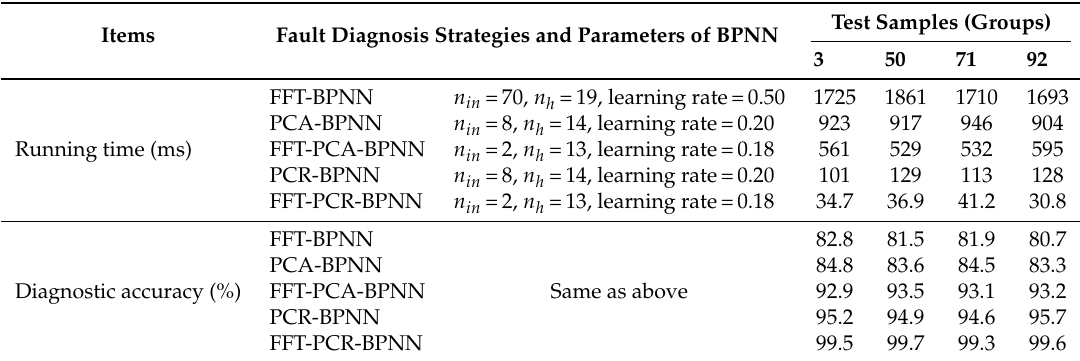
Table 4. Average fault diagnostic results based on different diagnosis strategies and the parameters of Back Propagation Neural Network